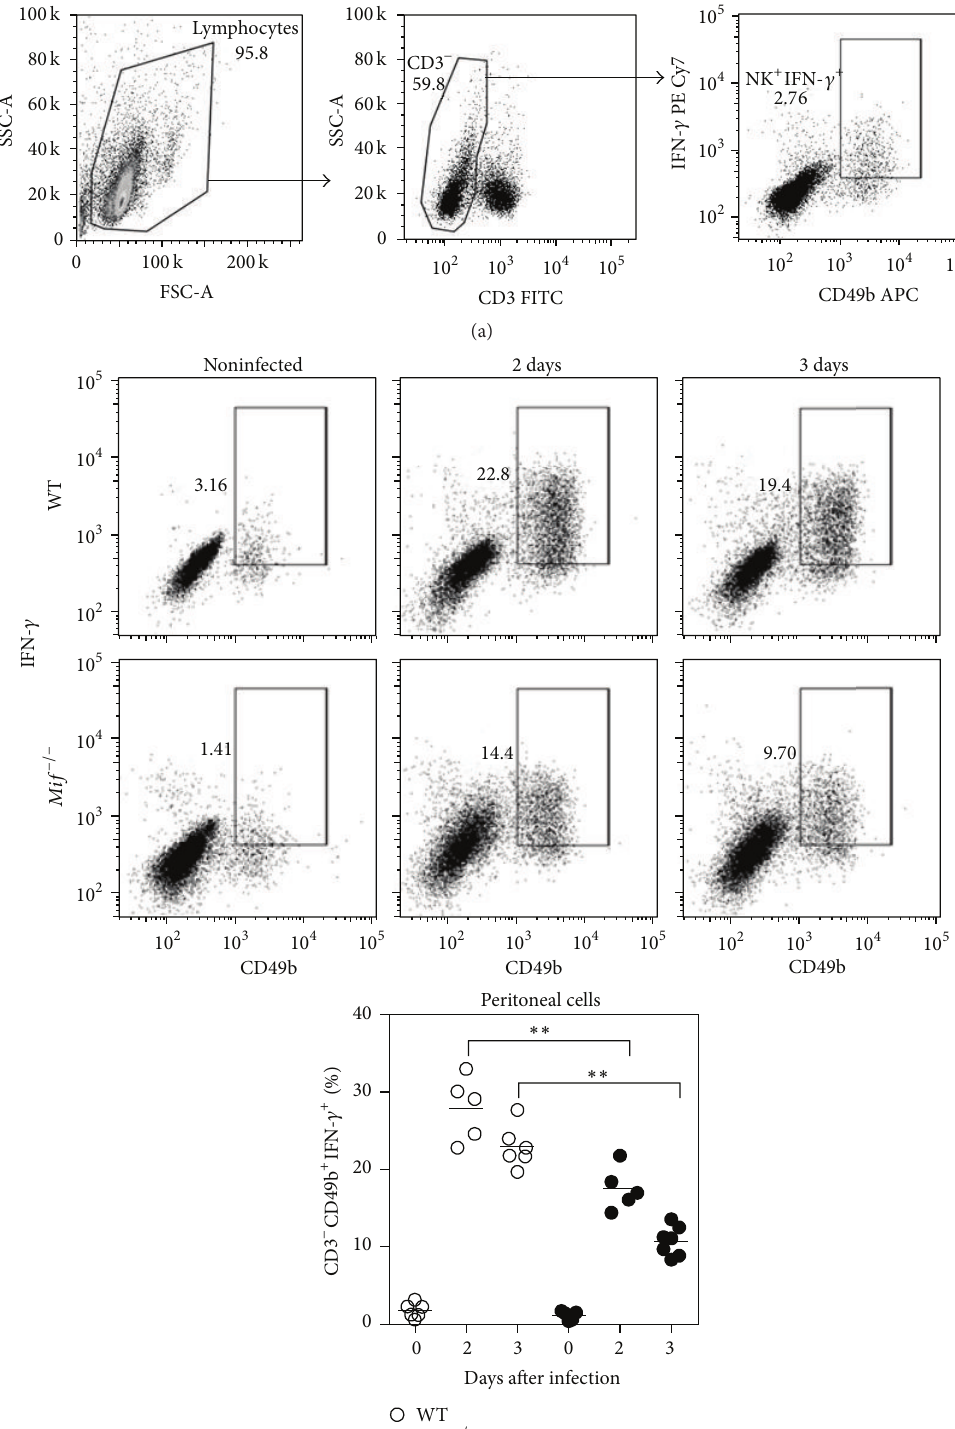
Figure 8: MIF promotes interferon- 𝛾 -producing NK cells during acute T. gondii infection. Peritoneal NK cells (CD3 − CD49b + ) from WT ( I ) and Mif −/− ( e ) mice were analyzed for intracellular IFN- 𝛾 at 0, 2, and 3 days after T. gondii infection. (a) Gating strategy of peritoneal NK cells. (b) Representative FACs (upper panel) and percentages of IFN- 𝛾 + NK cells (lower panel) during the acute phase of infection with T. gondii ( 𝑛 = 5-6 animals at each time point, representative of 3 independent experiments). Data are presented as the mean ± SE. ∗∗ 𝑃 < 0.01